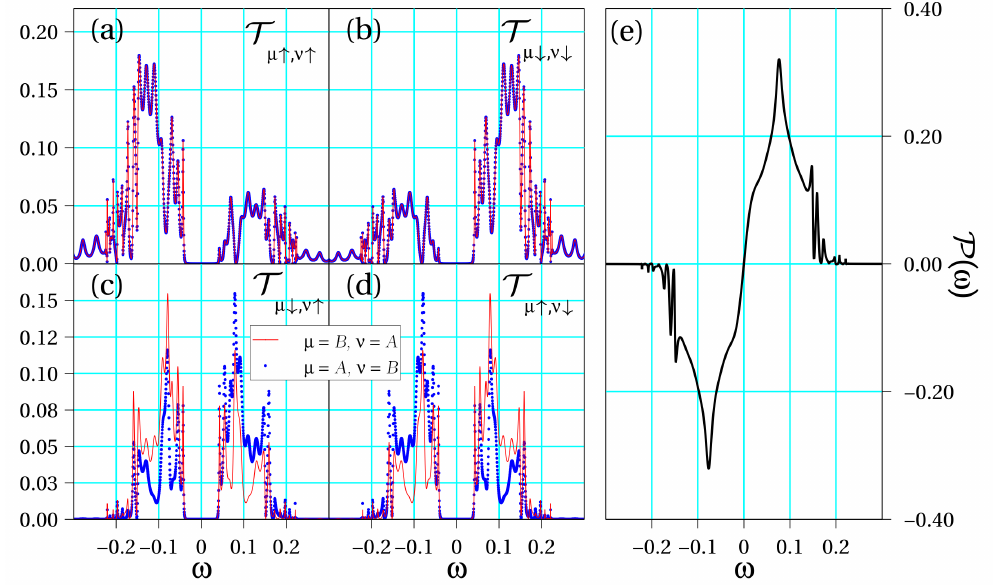
Figure 4. Transport coefficients obtained for an asymmetric molecule with the same parameters as in Figure 2 but t A = − 2 t B = 0.2 and 2 λ A = λ B = 0.02. Transmission coefficients ( a ) T µ ↑ , ν ↑ ( ω ) ; ( b ) T ( ω ) ; ( c ) T ( ω ) ; ( d ) T ( ω ) ; and ( e ) spin polarization P ( ω ) as a function of µ ↓ , ν ↓ µ ↓ , ν ↑ µ ↑ , ν ↓